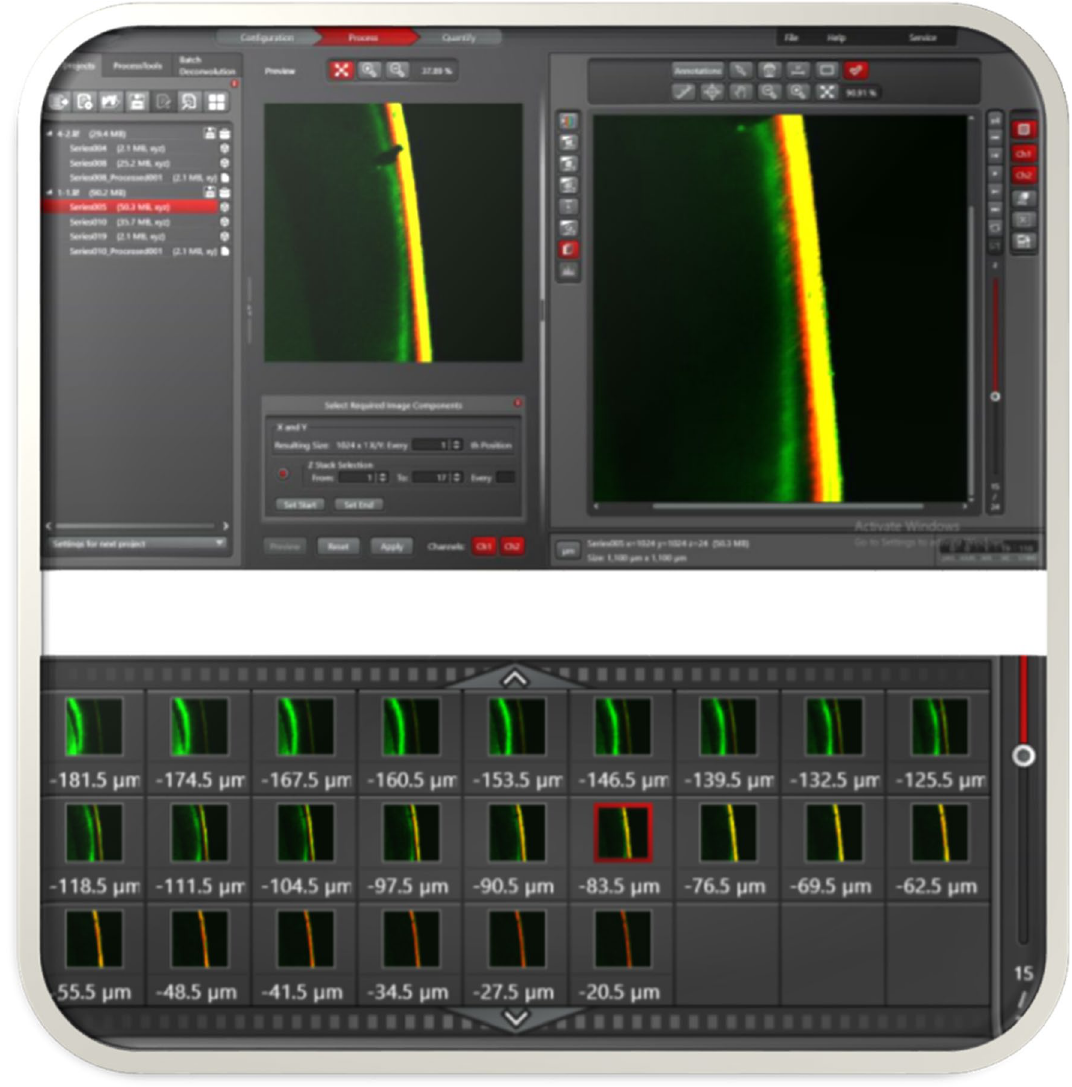
Figure 1. Examination of Z-stack images (3D) to select the most suitable single-plane according to LAS X 3D Visualization (Leica Microsystems GmbH, Wetzlar,